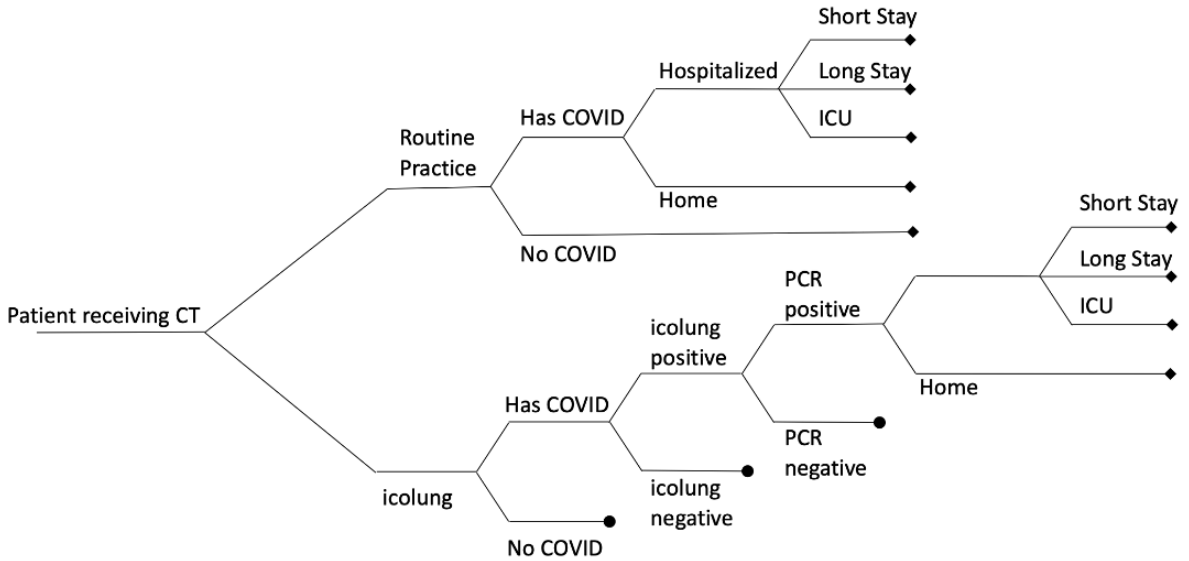
Figure 1. Decision analytic model. All branches terminating in a circle are collapsed to facilitate display, and are the same as branches already open.